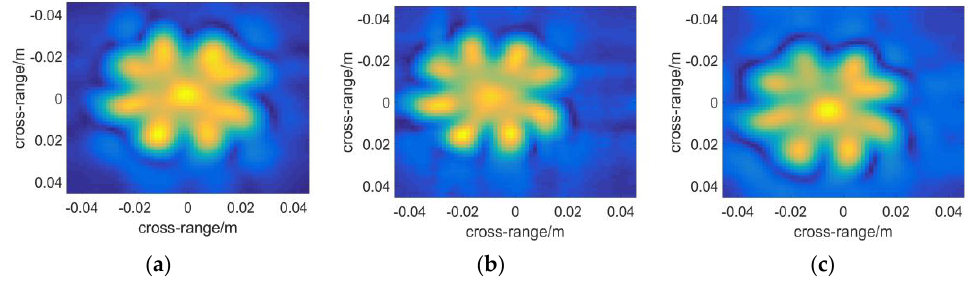
Figure 12. Slice figures of the metal fan at: ( a ) x = 0.398 with BPA; ( b ) x = 0.317 with RMA; ( c ) x = 0.397 with PMA.